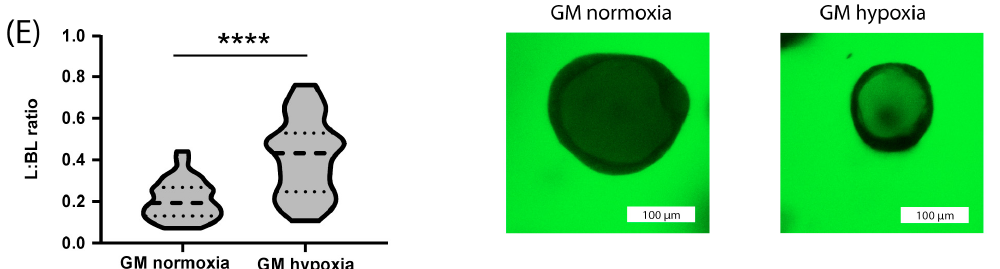
Figure 3. Effects of hypoxia on crypt-like (GM-cultured) HIO (monolayer- and 3D-cultured). ( A ) mRNA expression of IL8 (pro-inflammatory cytokine), OLFM4 (stem cells), LYZ (Paneth cells), PEPT1 (di/tri-peptide transporter), LAT2 (amino acid transporter) and HIF1A (hypoxia-regulated transcription factor). Data are reported as relative expression compared to normoxia (set at 1) and displayed as median with interquartile range. Results were obtained from three different HIO donors (depicted by different data point symbols, one symbol type per donor). * p 0.05, **** p 0.0001. ≤ ≤ ( B ) Analysis of the % of surface area positive for CC3 and representative images from immunoflu- orescence staining of CC3 in crypt-like HIO monolayers exposed to hypoxia for 24 h compared to normoxic controls. Data are displayed as median with interquartile range. Results were obtained from three different HIO donors (depicted by different data point symbols, one symbol type per donor). Scale bars indicate 100 µ m. ** p 0.01. ( C ) Analysis of the % of cells positive for Ki67 and rep- ≤ resentative images from immunofluorescence staining of Ki67 in crypt-like HIO monolayers exposed to hypoxia for 24 h compared to normoxic controls. Data are displayed as median with interquartile range. Results were obtained from three different HIO donors (depicted by different data point symbols, one symbol type per donor). Scale bars indicate 100 µ m. ** p 0.01. ( D ) Representative ≤ images from immunofluorescence staining of ZO1 in crypt-like HIO monolayers exposed to hypoxia for 24 h compared to normoxic controls. Results were obtained from three different HIO donors. Scale bars indicate 100 µ m. ( E ) FITC-D4 paracellular barrier assay with representative images of crypt-like 3D HIO exposed to hypoxia for 16 h compared to controls. FITC-D4 fluorescence intensity is expressed as a luminal (L) to basolateral (BL) ratio. Per group, at least 10 HIO were measured in three different donors. Scale bars indicate 100 µ m. **** p 0.0001. Abbreviations: IL8—interleukin ≤ 8; OLFM4—olfactomedin 4; LYZ—lysozyme; PEPT1—peptide transporter 1; LAT2—L-type amino